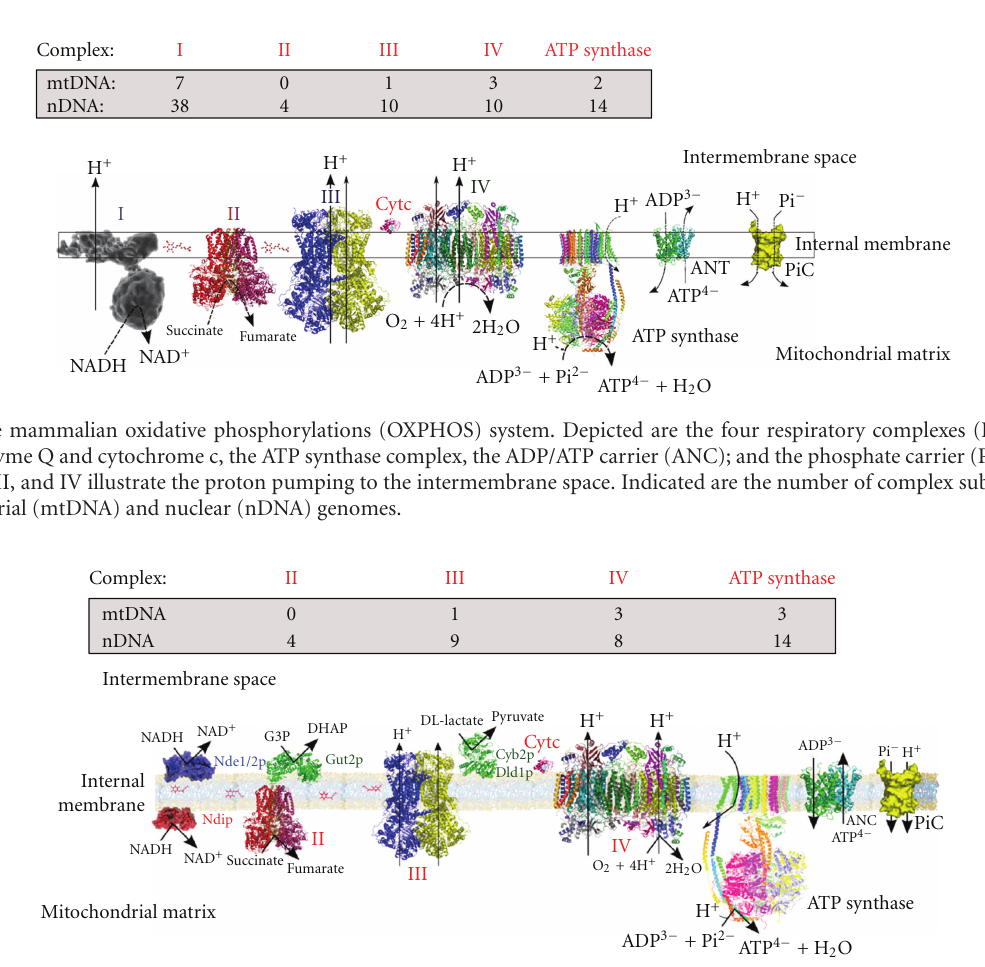
Figure 2: The Saccharomyces cerevisiae oxidative phosphorylations (OXPHOS) system. The main di ff erences with the mammalian OXPHOS system are the absence of complex I that is substituted by external and internal NADH dehydrogenases, and the presence of D, L-lactate dehydrogenases, which transfer electrons directly to cytochrome c. Indicated are the number of protein subunits encoded by mitochondrial (mtDNA) and nuclear (nDNA)